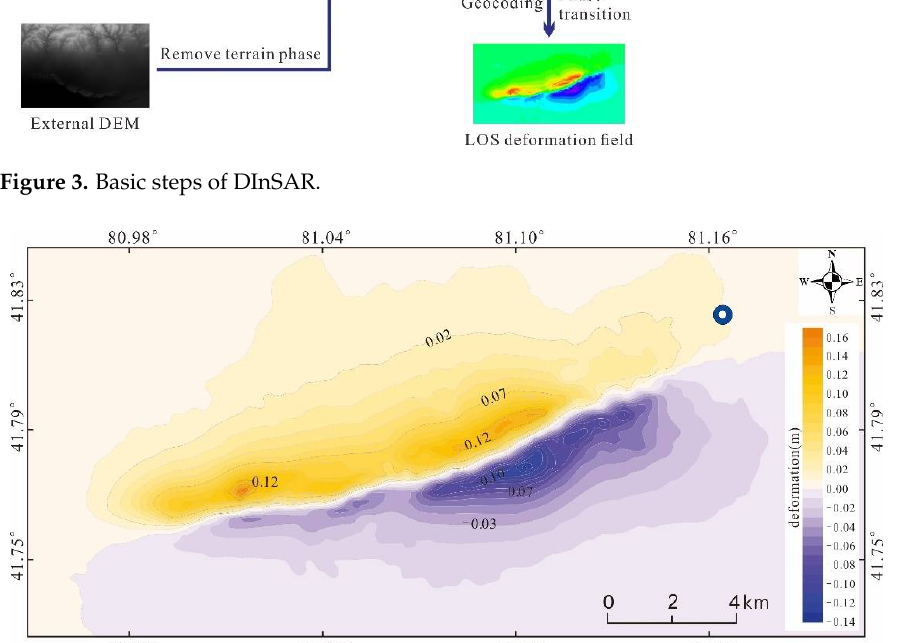
Figure 4. Surface deformation projected along the radar line of sight, obtained from DInSAR analy- sis. Location of the hypocenter, drawn as a blue circle.